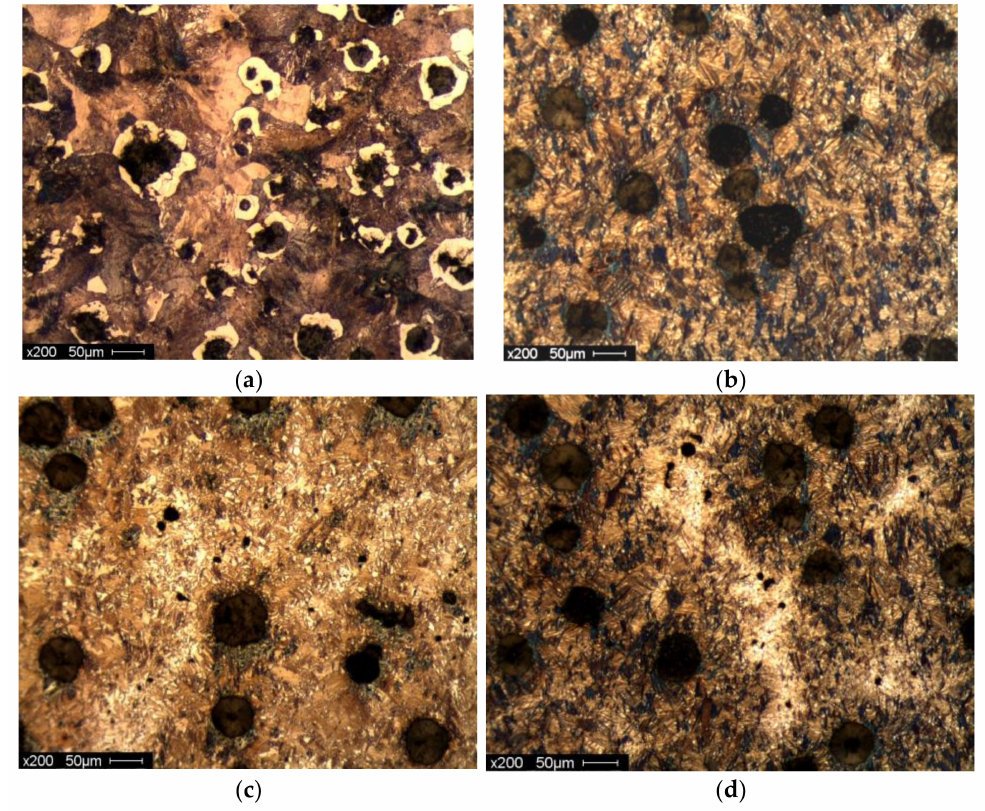
Figure 27. Optical micrographs of ( a ) as-cast sample; ( b ) 10 min at 275 ◦ C; ( c ) 60 min at 350 ◦ C; and ( d ) 60 min at 325 ◦ C.